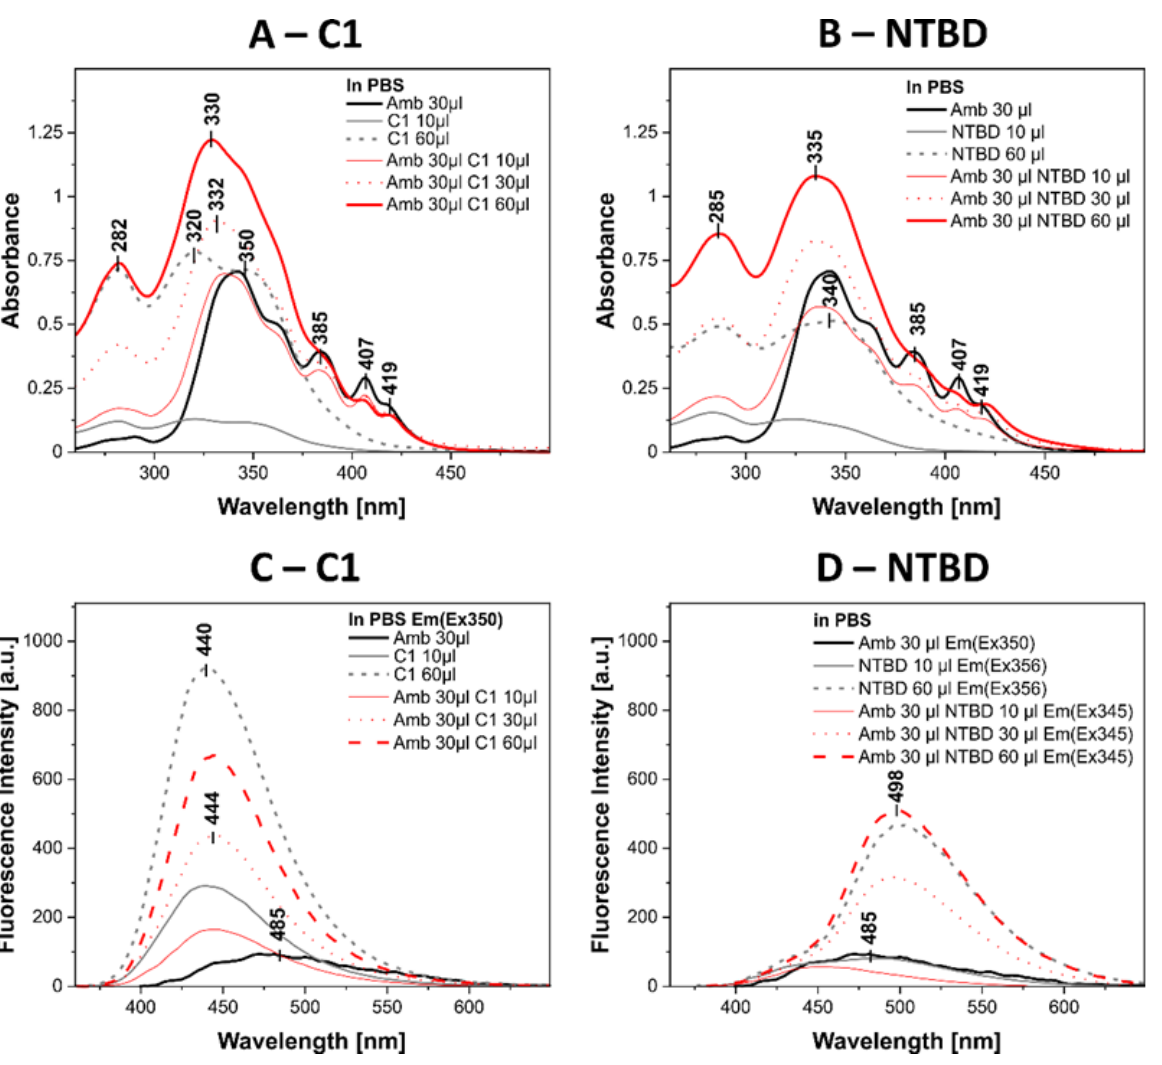
Figure 9. ( A )—electron absorption spectra for C1, AmB, and the C1+AmB synergistic system in PBS buffer at varying concentrations of the compound. The molar concentration of AmB was 0.0107 mM, and the molar concentration of C1 was 0.0159 mM for the 10 µ L dose and 0.0942 mM for 60 µ L. The successive molar concentrations of C1 in the synergistic system were 0.0158 mM, 0.0471 mM, and 0.0933 mM; ( B )—electron absorption spectra for NTBD, AmB, and the NTBD+AmB synergistic system in PBS buffer at varying concentrations of the compound. The molar concentration of AmB was 0.0107 mM, and the molar concentration of NTBD was 0.0099 mM for the 10 µ L dose and 0.0587 mM for 60 µ L. The successive molar concentrations of compound NTBD were 0.0098 mM, 0.0294 mM, and 0.0581 mM; ( C )—electron emission spectra corresponding to the absorption spectra in A; ( D )—electron emission spectra corresponding to the absorption spectra in